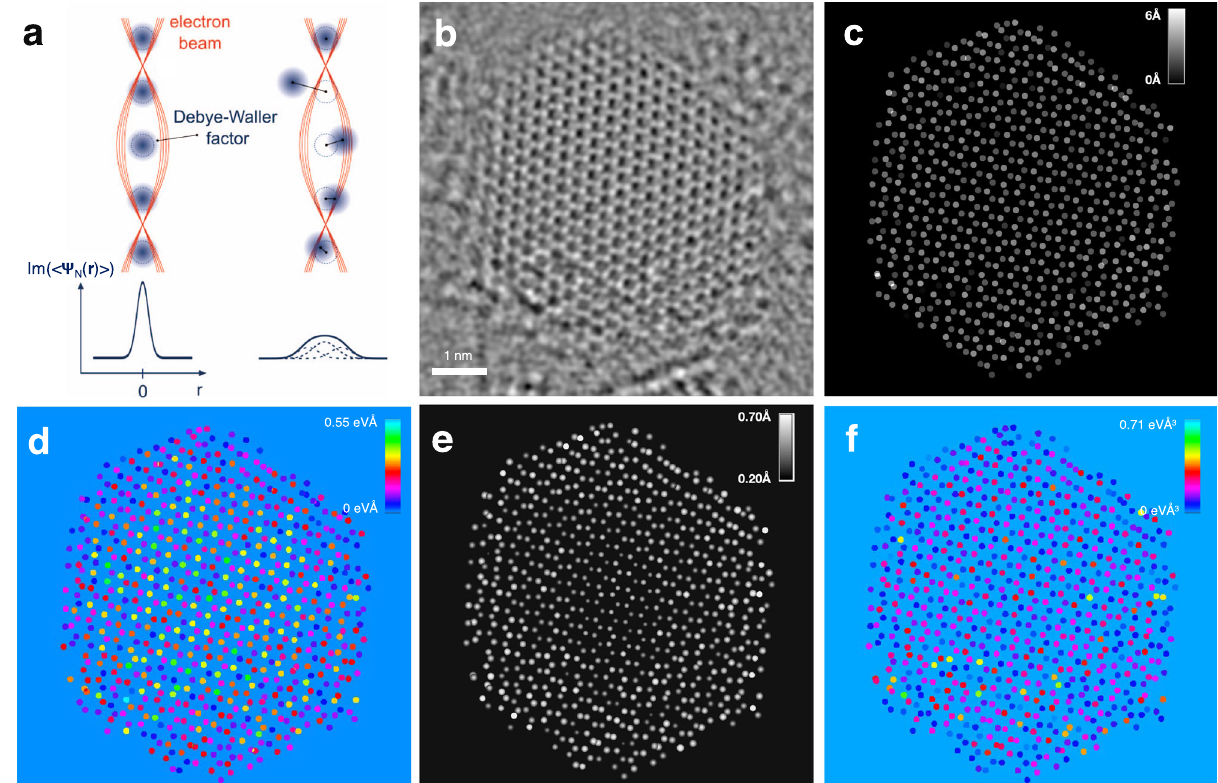
Fig. 1 Dynamic analysis of an exit wave. a Illustration of the generic model Eq. (1) of the exit wave imaginary part Im(< Ψ N ( r )>) from a static column of atoms, modulated by DW factors, and a dynamic column with atom excursions exceeding the DW value. b – f Benchmark application of model Eq. (1) to the analysis of a Co – Mo – S nanocrystal. b The imaginary part of the EW1 of a Co – Mo – S nanocrystal viewed in <001> orientation. c Height map showing the atomic column positions along the beam direction with respect to a common image plane as a function of the position in the image plane. d V /( π R 2 ) map showing the projected atomic column potentials scaled by the averaged area of the atoms. e R av map showing the spread radius of the atomic columns. f V map showing the integrated potential of the atomic